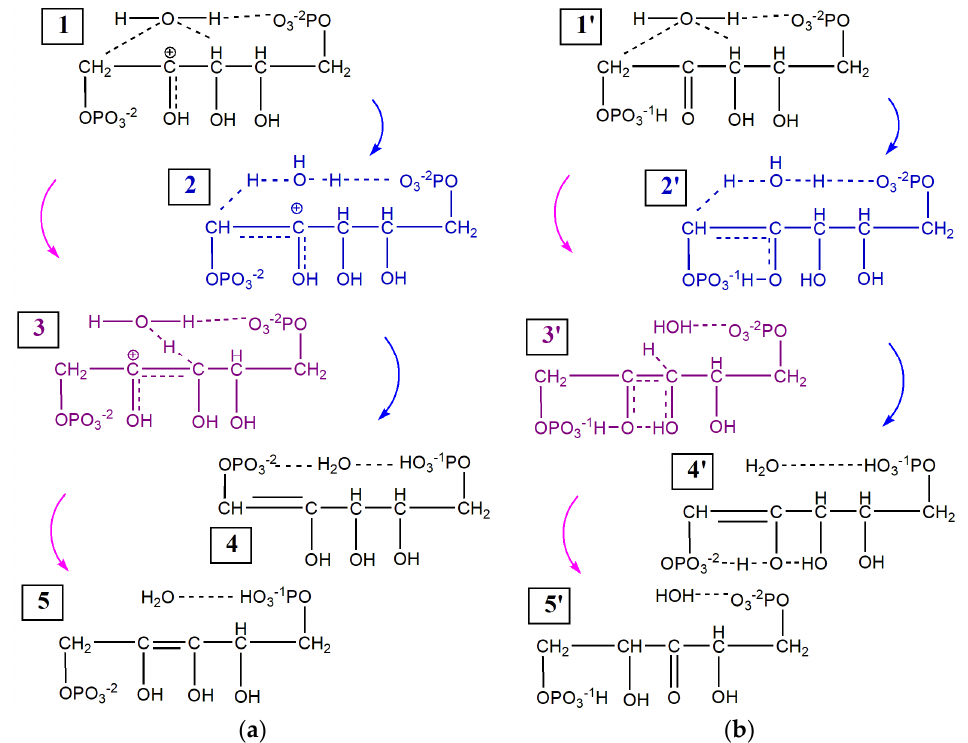
Figure 3. The scheme of enolization via proton detachment from C 1 (blue) and C 3 (purple) carbons in: ( a ) RuBP1 + ⋅ H 2 O; ( b ) RuBP2 + ⋅ H 2 O. The initial states are (1) and (1 ′ ). The states corresponding to the top of the barrier (2), (3) and (2 ′ ), (3 ′ ) are colored. The products of enolization are as follows: (Z)-5-(hydrogen phosphonatooxy)-2,3,4-trihydroxypent-1-enyl phosphate—states (4) and (4 ′ ), (Z)-5-(hydrogen phosphonatooxy)-2,3,4-trihydroxypent-2-enyl phosphate—tate (5). The product of tauto-merization is 5-(hydrogen phosphonatooxy)-2,4-dihydroxy-3-oxopentyl phosphate— state (5 ′ ).